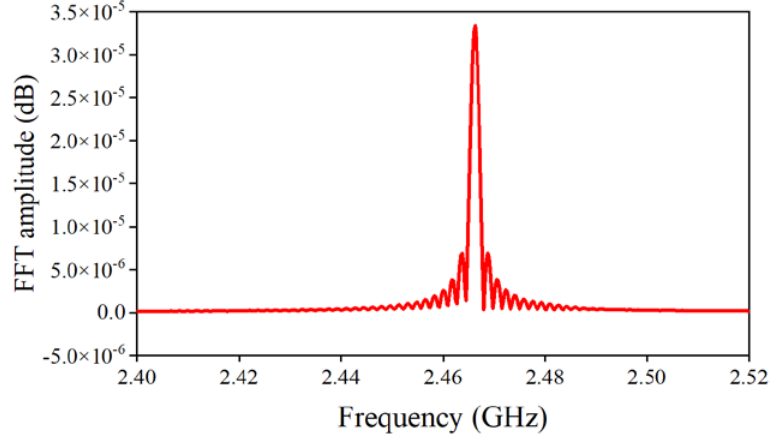
Figure 5. The output spectrum under stable operation.